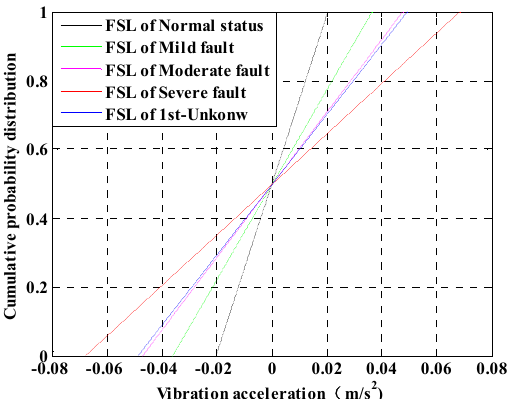
Figure 7. The first transformer's vibration signal cumulative probability distribution curve FSL comparison diagram.